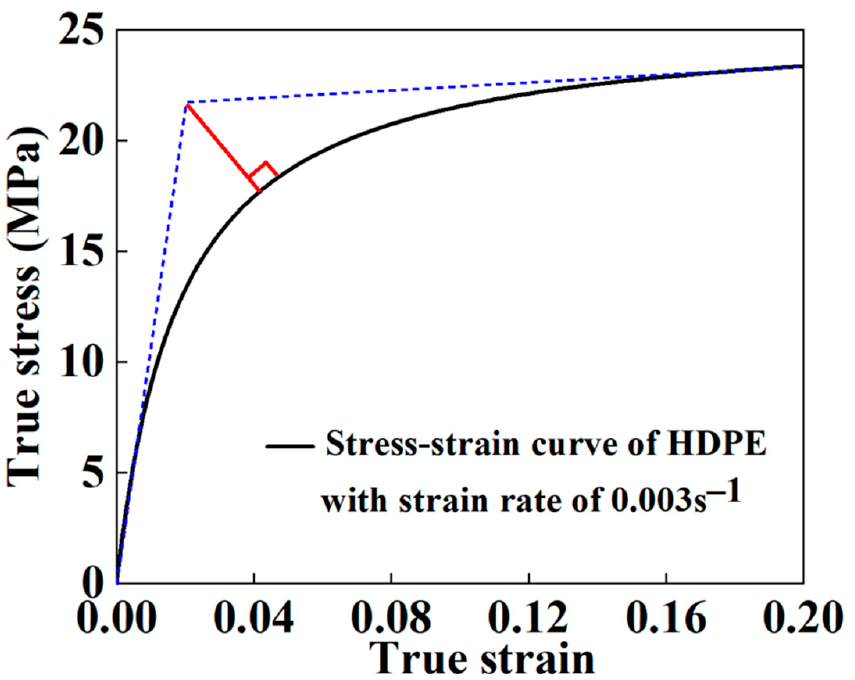
Figure 5. Stress–strain curve of the HDPE at strain rate of 0.003 s − 1 .